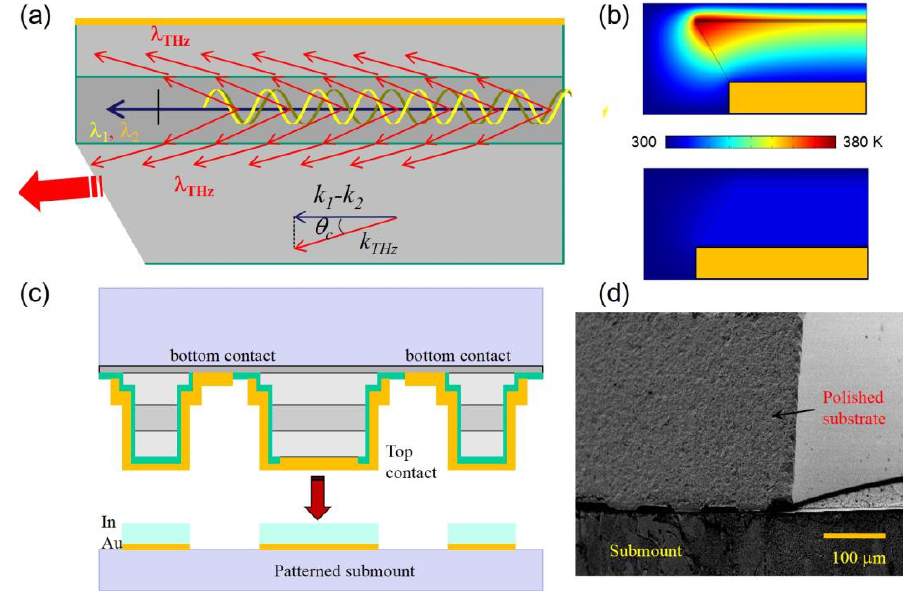
Figure 4. ( a ) Schematic of Čerenkov phase matching in a mid-IR quantum cascade lasers; ( b ) The thermal distributions of the epi-up and epi-down mounted Čerenkov devices; and ( c , d ) schematic of the epi-down mounting scheme and the SEM image of an epi-down mounted device.